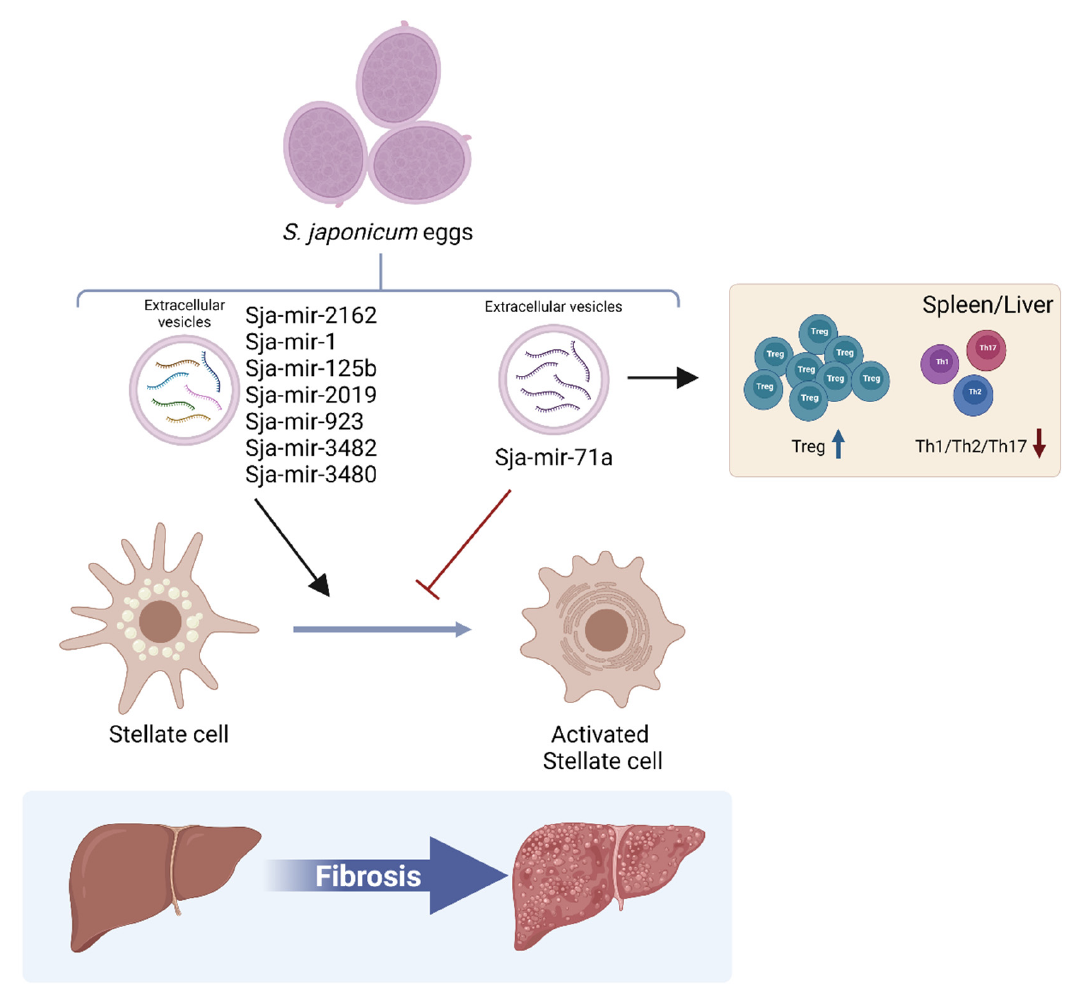
Figure 2. Eggs of S. Japonicum can release extracellular vesicles, which transport different miRNA cargo that can be internalized by host cells as liver stellate cells and exert distinct effects. These miRNAs can repress the genic expression of host-cell molecular targets, promoting the activation of liver stellate cells. This has been associated with the generation of liver fibrosis. In contrast, Sja-mir-71a can inhibit the activation of stellate cells and prevent fibrosis. Additionally, Sja-mir-71a induces a reduction in Th1, Th2, and Th17 cells in the liver and spleen, having immunomodulatory functions that possibly influence the characteristics of the microenvironment in host tissues. Created using